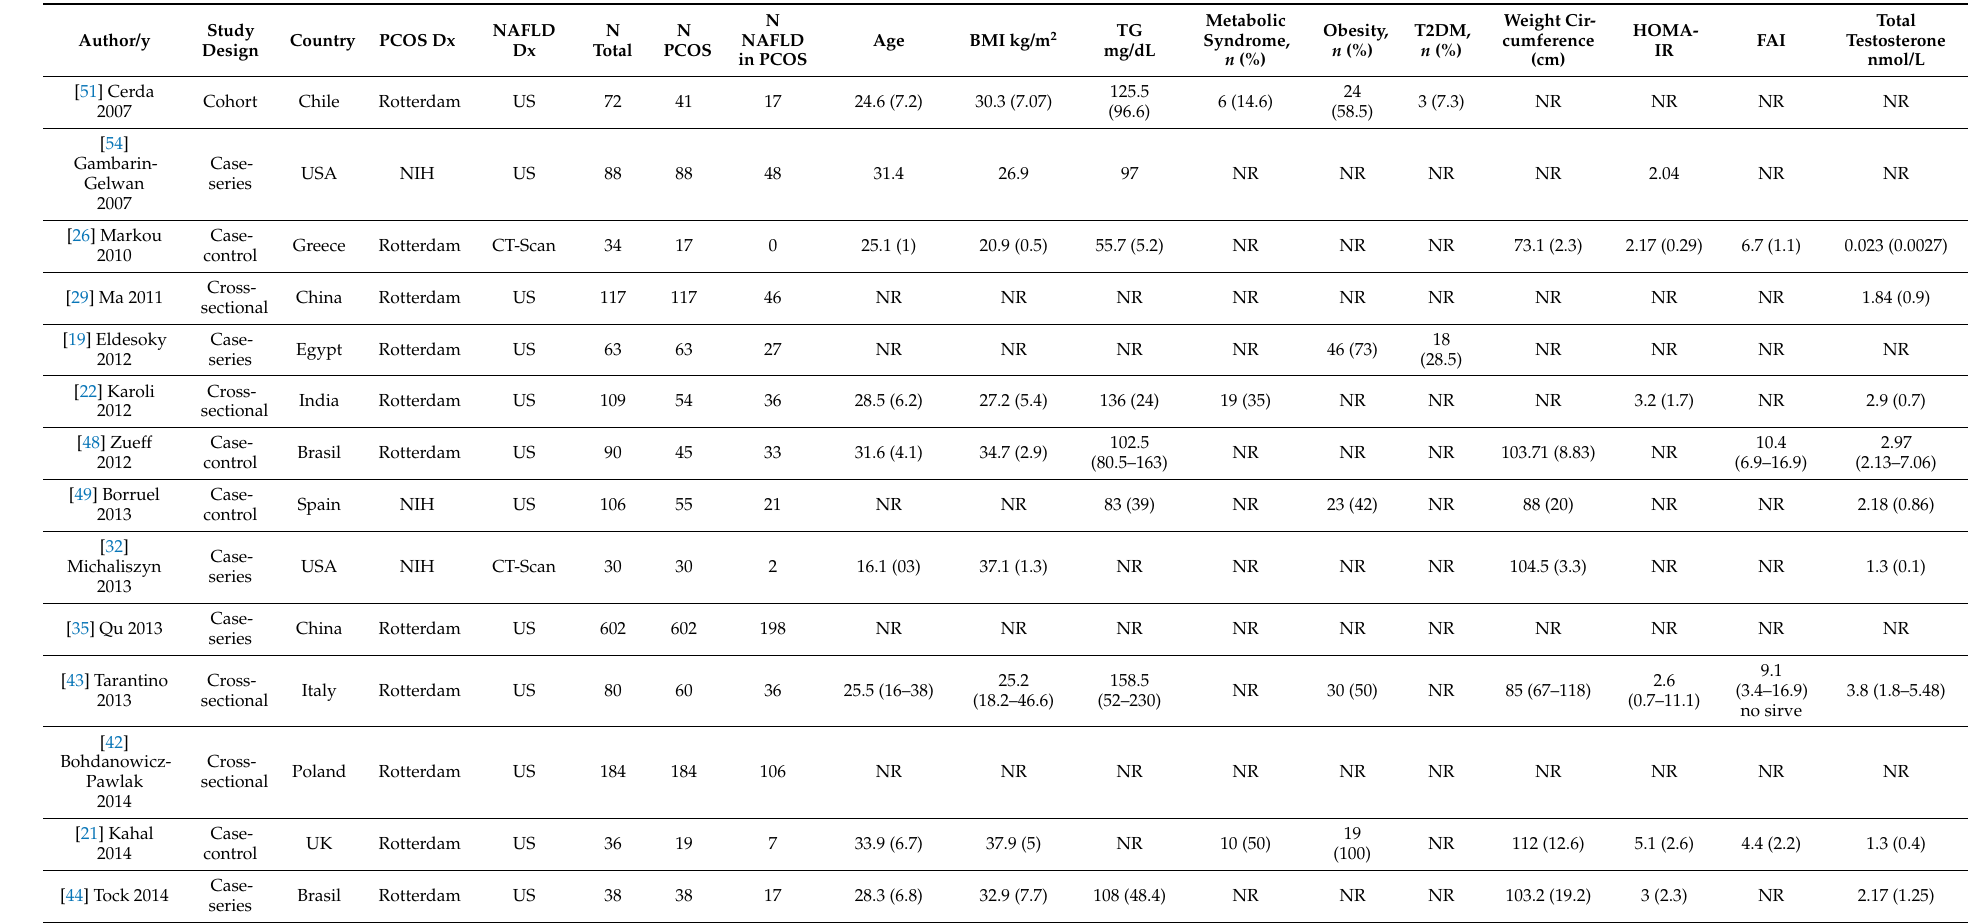
Table 1. Study and Patients’